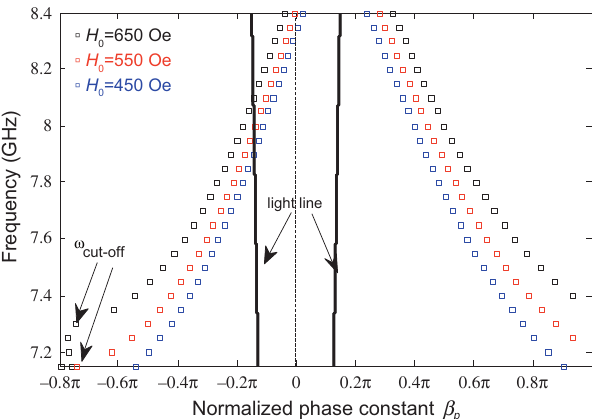
Figure 13. Dispersion curves of the unit-cell design in Figure 12 calculated for 3 different bias field strengths, H 0 = 450, 550, 650 Oe. Tunability of the dispersion curves is limited because the operation frequency is far away from the ferromagnetic resonance of the YIG substrate.